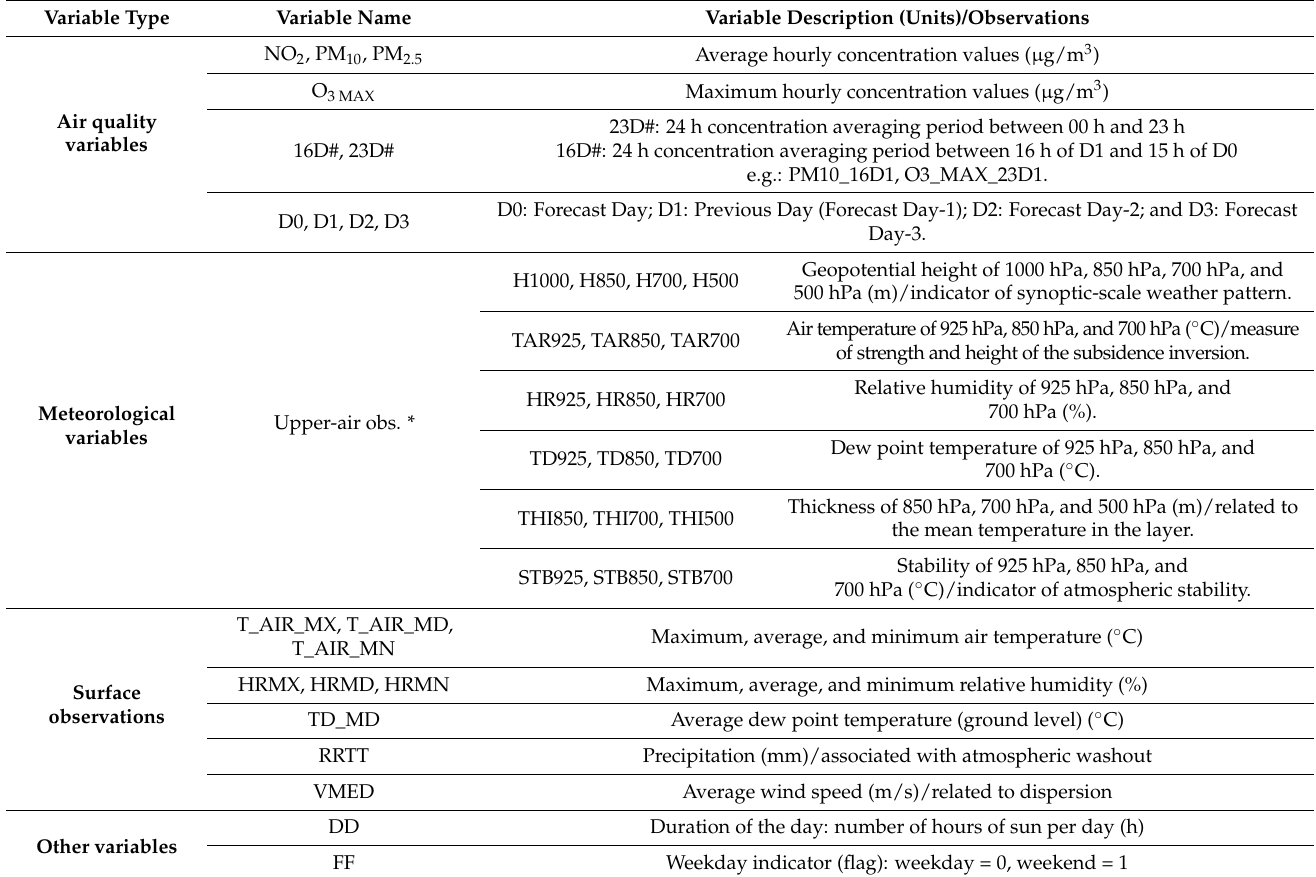
Table 1. Variables considered as predictors in the machine learning models in the air quality